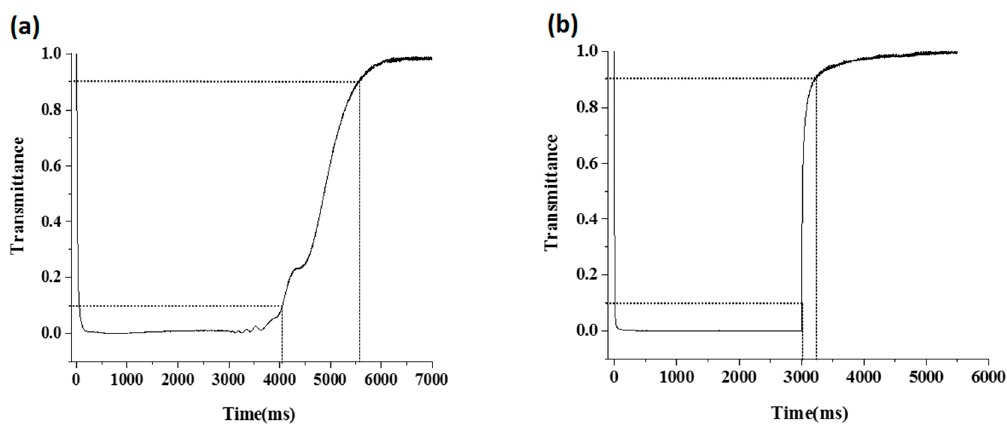
Figure 7. Experimental platform for measuring the response time of the MAs.